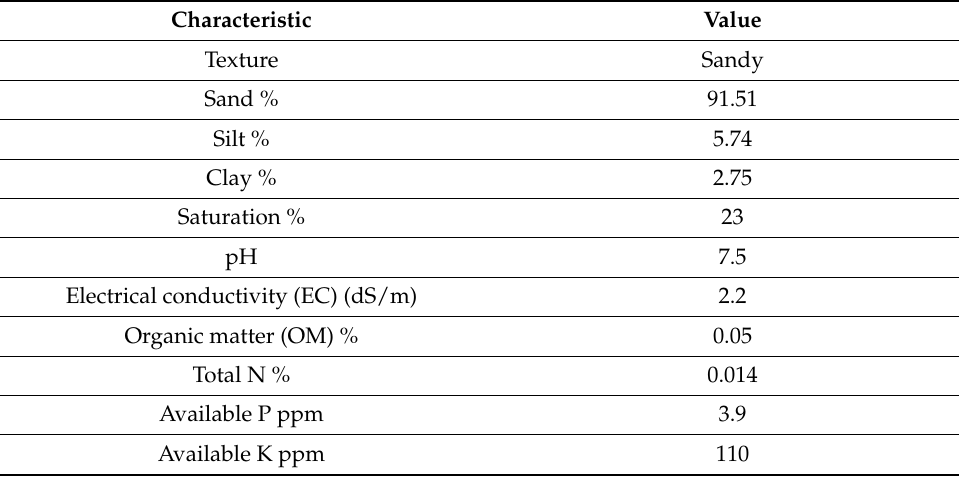
Table 1. Physical and chemical properties of the experimental soil.